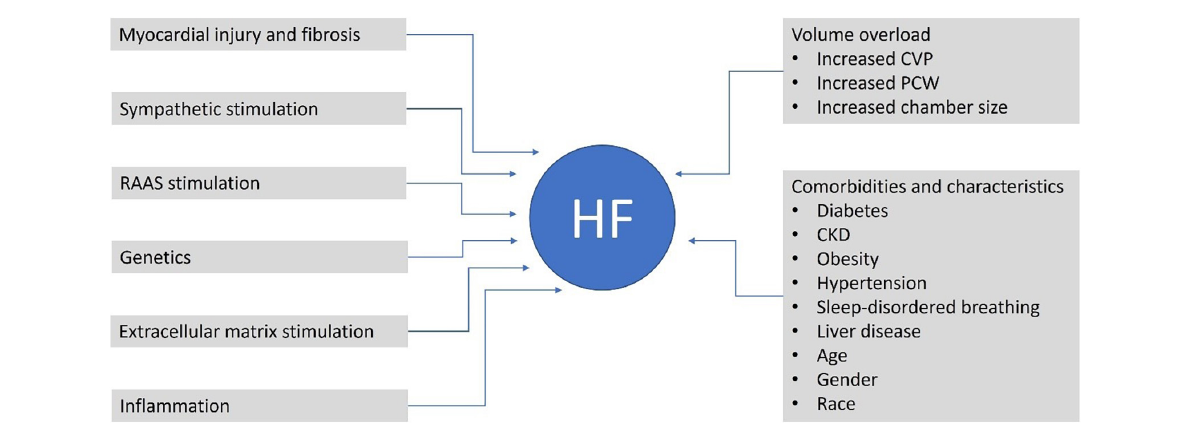
FIGURE1 Potential contributors and mechanisms contributing to HF that could be altered by sacubitril/valsartan or are common characteristics of patients with HF. CKD, chronic kidney disease; CVP, central venous pressure; HF, heart failure; PCWP, pulmonary capillary wedge pressure; RAAS, renin-angiotensin-aldosterone